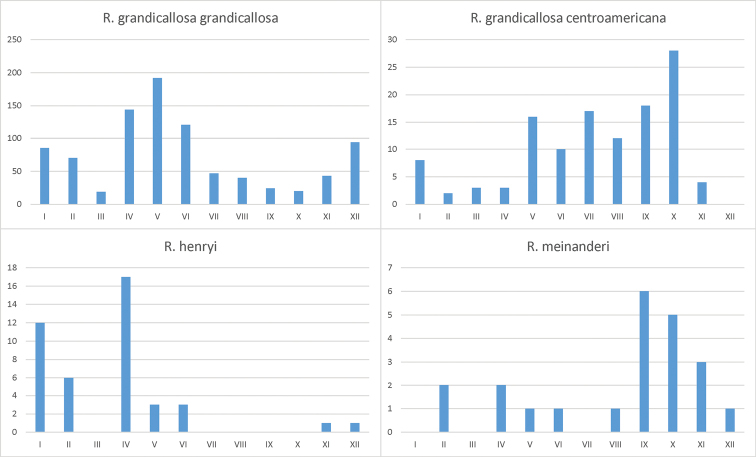
Annual distribution of collected Rhyncholepta specimens. 94Rh.grandicallosagrandicallosa Bergroth, 1911 (899 specimens with dates analysed) 95Rh.grandicallosacentroamericana subsp. n. (121 specimens) 96Rh.henryi sp. n. (43 specimens) 97Rh.meinanderi Becker & Grazia-Vieira, 1971 (22 specimens).